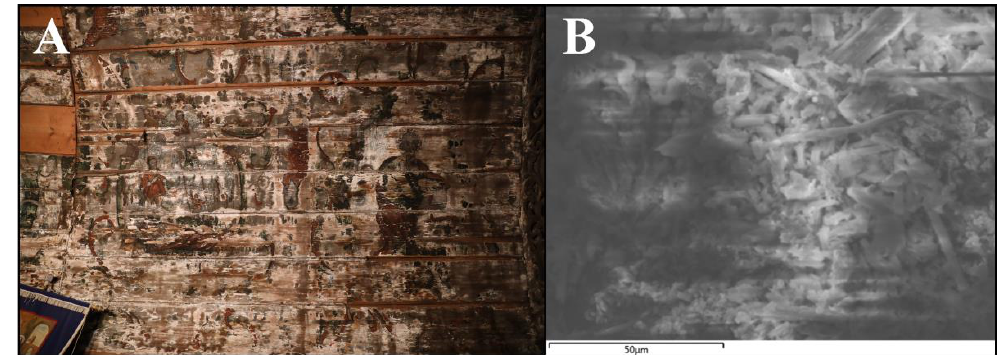
Figure 9. Details of the painting on canvas in the monument wooden church wall. ( A ) — Painting on the hemp fabric on the walls of the monument wooden church; ( B ) — SEM image magnification ×50 .